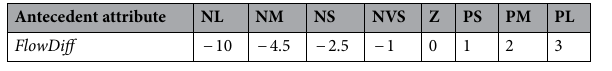
Table 5. The optimal references of the FlowDiff.